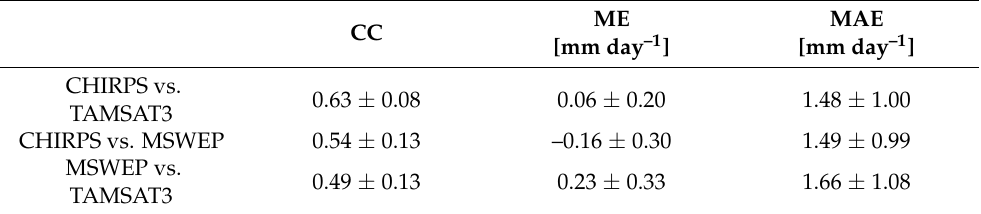
Figure 13. Maps of CC ( a ), ME (mm day –1 ) ( b ) and MAE (mm day –1 ) ( c ) for EA. Table 5. CC, ME and MAE spatially averaged over EA with corresponding standard deviations.